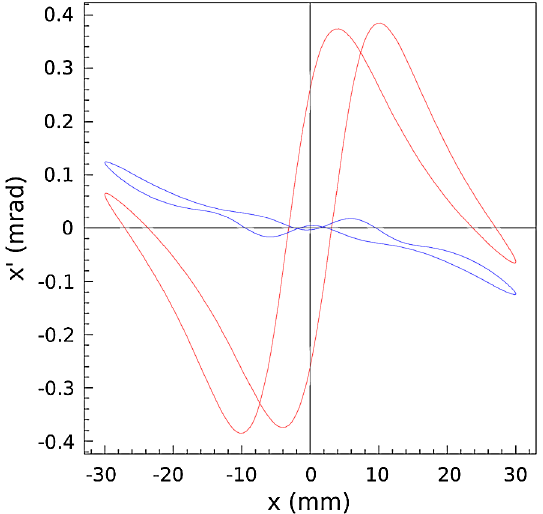
FIG. 14. Horizontal kick in mrad and displacement in mm for an electron passing the UE112 at 20 mm gap and maximum phase for initial variables x and x 0 equally distributed on a phase space ellipse (see text). The red line corresponds to the un- shimmed device and the blue line shows the results with an L -shim